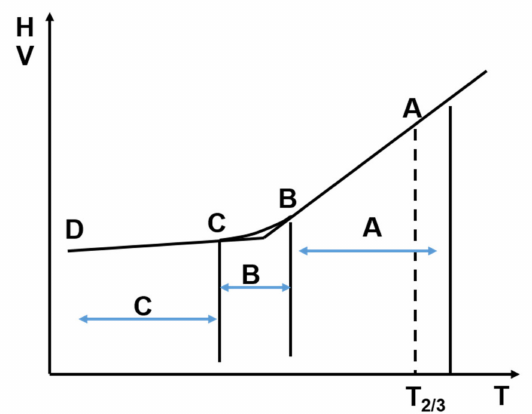
Figure 1. Illustration of relaxation phenomena in the supercooled melt during glass formation. A: the system is in internal equilibrium; B: relaxation during the experiment; C: the system is totally frozen. Adopted from [21], with permission from AIP Publishing LLC,